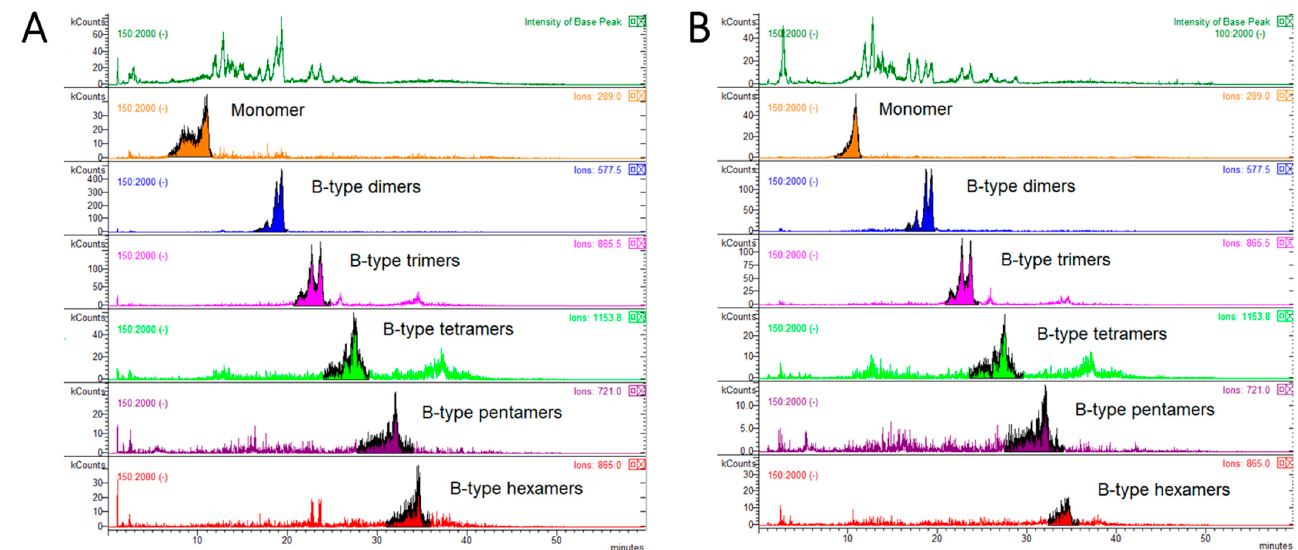
Figure 4. HPLC-MS chromatograms showing the distribution of type-A procyanidins in dry larch bark powder (panel A ) and larch bark extract (panel B ).